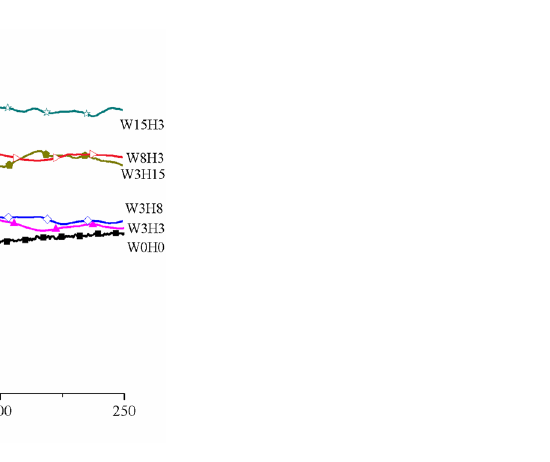
Figure 4. The DSC curves of the composites